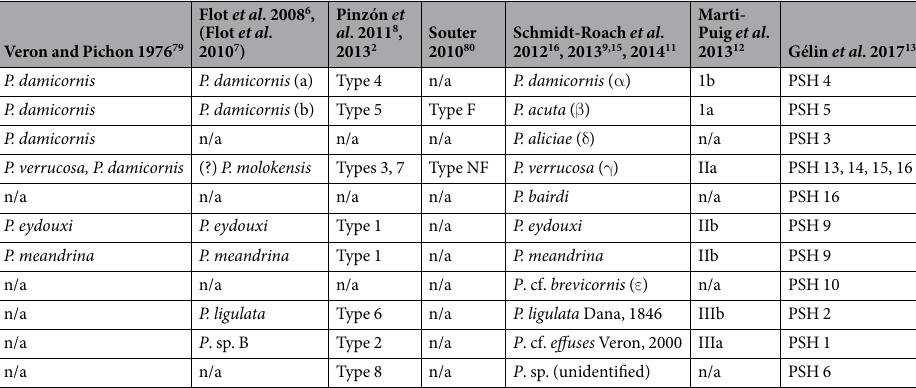
Table 1. Summary of the taxonomic names and genetic lineages for identification of Pocillopora used to